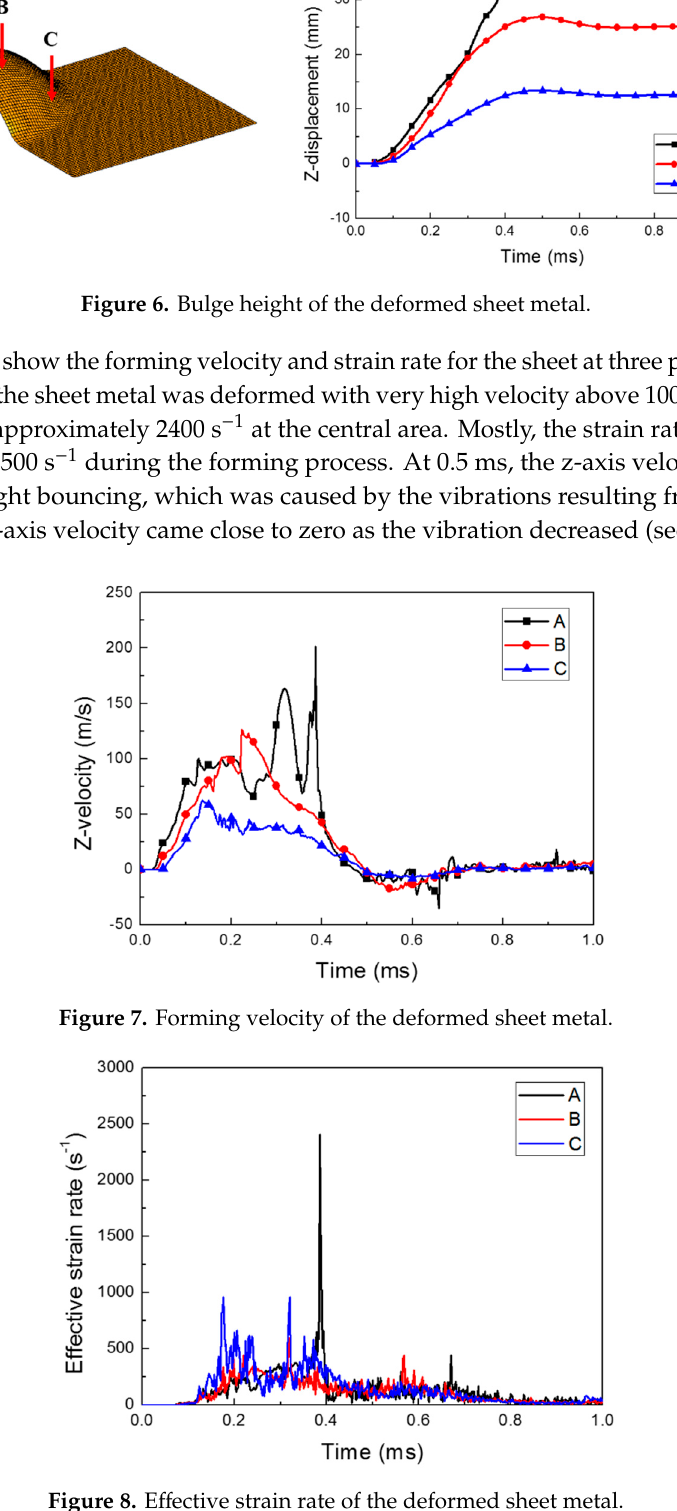
Figure 5. Pressure distribution of the fluid parts in the numerical simulation (unit: MPa).